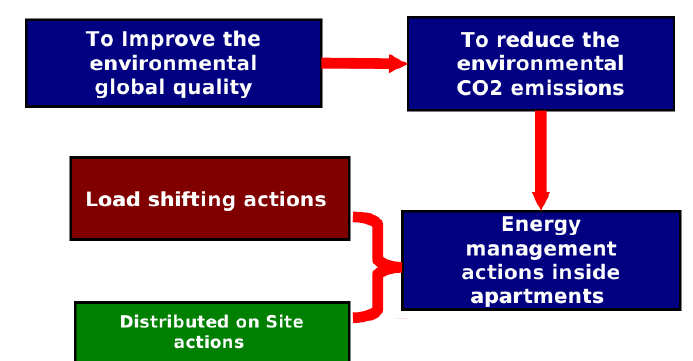
Figure 5. Global